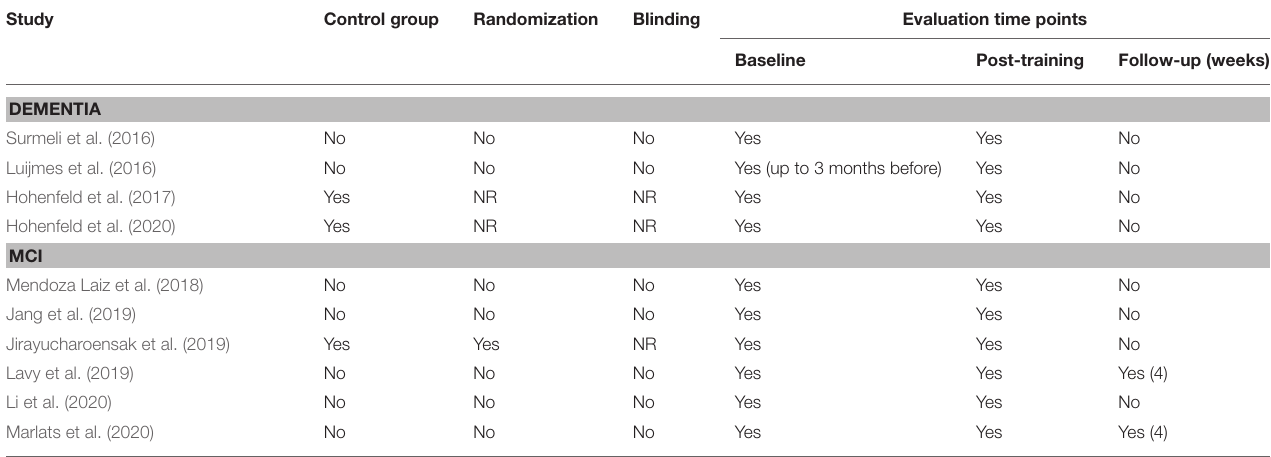
TABLE 3 | Summary of study design. Study